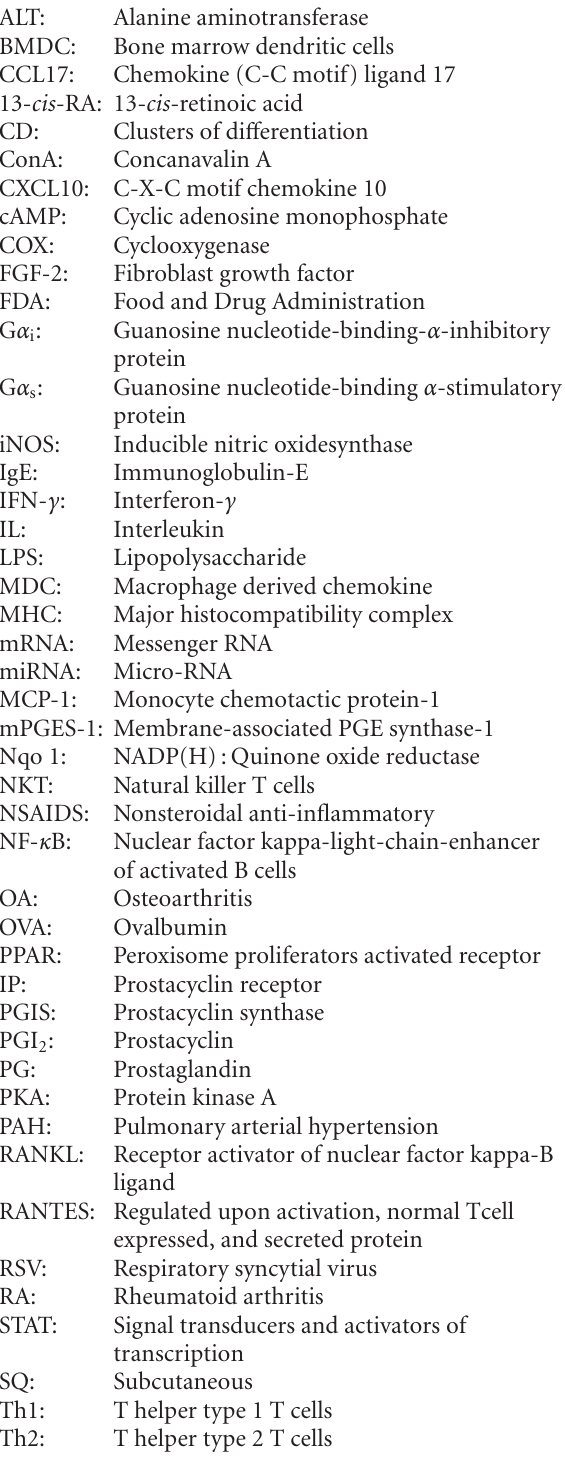
TGF- β : Transforming growth factor- β TNF- α : Tumor necrosis factor- α VNTR: Variable-number tandem repeat VEGF: Vascular endothelial growth